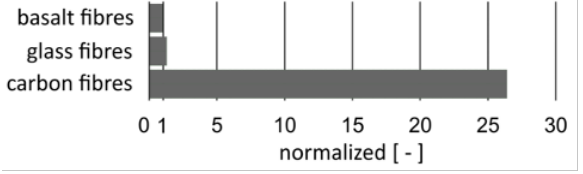
Figure 3. Comparison of the GWP of di ff erent fibre types (normalized values).